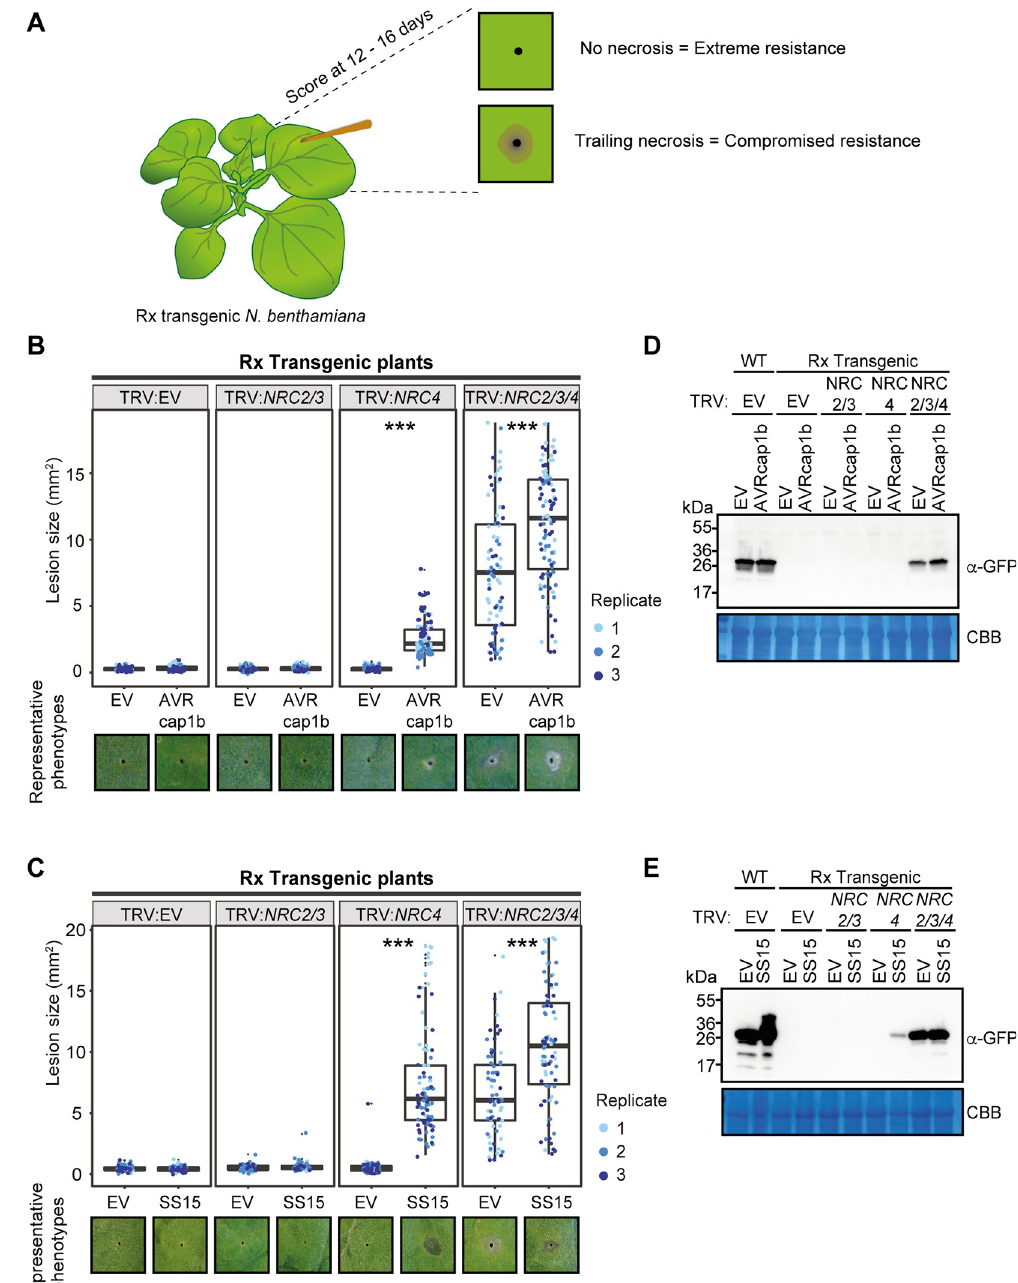
Fig 5. AVRcap1b and SS15 compromise Rx-mediated extreme resistance to PVX in NRC4-silenced plants. (A) Toothpick inoculation method previously described by Wu and colleagues allowed examination of the spread of trailing necrotic lesions due to the partial resistance mediated by Rx. EV, NRC2, NRC3, or NRC4 were silenced individually or in combination in Rx-transgenic N . benthamiana plants by TRV. (B) EV or AVRcap1b and (C) EV or SS15 were expressed, via agroinfiltration, in leaves of the NRC-silenced plants 1 day before PVX inoculation. PVX-GFP (pGR106-GFP) was inoculated using the toothpick inoculation method, as per panel (A). Photographs were taken 12–16 days after PVX inoculation. The size of the necrotic lesions was measured using Fiji (previously ImageJ) (S8 Data). Data acquired from different biological replications are presented in different colours. Statistical differences among the samples were analysed with mixed model ANOVA and a Tukey HSD test ( p- value < 0.01), where the fixed effect is the silencing treatment (TRV: EV, TRV: NRC2/3 , TRV: NRC4 , TRV: NRC2/3/4 ) with either EV or AVRcap1b and the random effect is the experimental replicate. Significant differences between the conditions are indicated with asterisks ( ��� , p- value < 0.0001) (S9